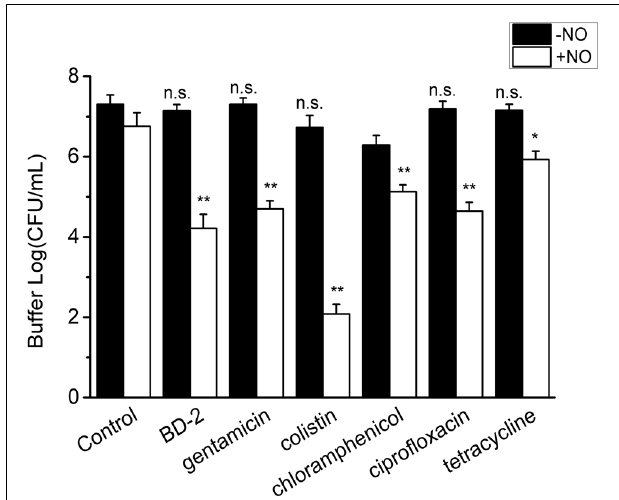
FIGURE 5 | Efficacy of 3 h treatment of BD-2 and antibiotics against 7-day P. aeruginosa biofilm released cells in PBS in the absence and presence of NO release. The concentration of BD-2 is 20 µ g/mL, and concentration for all other antibiotics is 100 µ g/mL. NO flux is 1.5. Asterisk denotes statistical significance compared with the control samples ( n = 3 catheters for treatment, n.s., no significance, ∗ p < 0.05; ∗∗ p < 0.01).